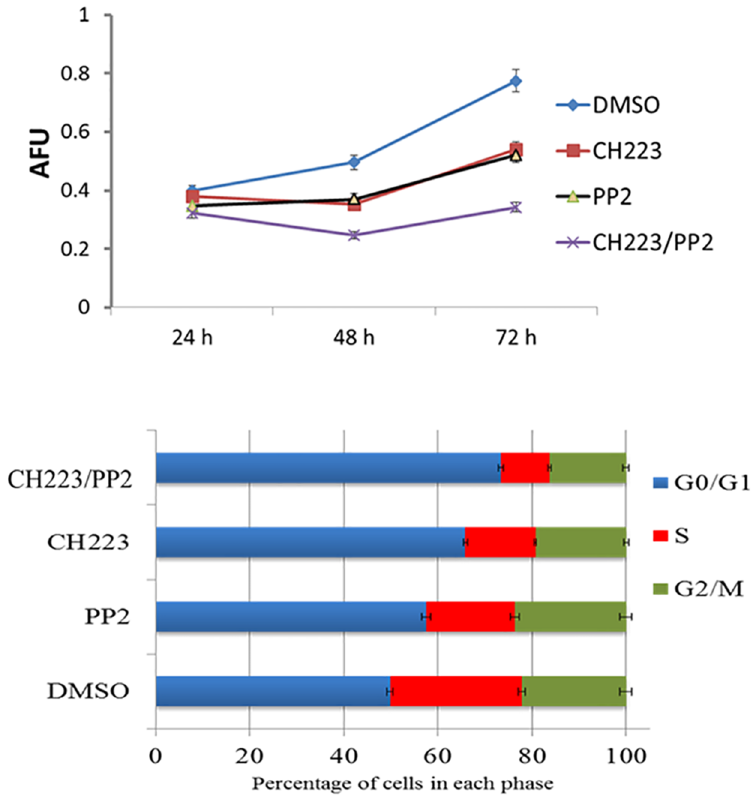
Fig 4. CH223191 and PP2 have a synergistic effect on proliferation of C4-2 prostate cancer cells. Cells were grown in 96 well plates at 5.0 × 10 3 cells per well. The cells were treated with DMSO or 50 μ M of CH223191 or 30 μ M of PP2 alone or in combination for 24–72 hrs. (A) Cell growth was measuredusing Promega CellTiter 96 Cell Proliferation Assay per manufactures instructions. Each bar represents mean ± SEM (n = 3), * p < .05. (B) The cells were plated at a density of 1x10 6 cells/dish and exposedto DMSO or 50 μ M of CH223191or 30 μ M of PP2 alone or in combination for 72 hrs. Cells were harvestedand analyzed for cell cycle. The cells with DMSO exposureserved as control. Bar graphs represent mean ± SD of three separateexperiments.